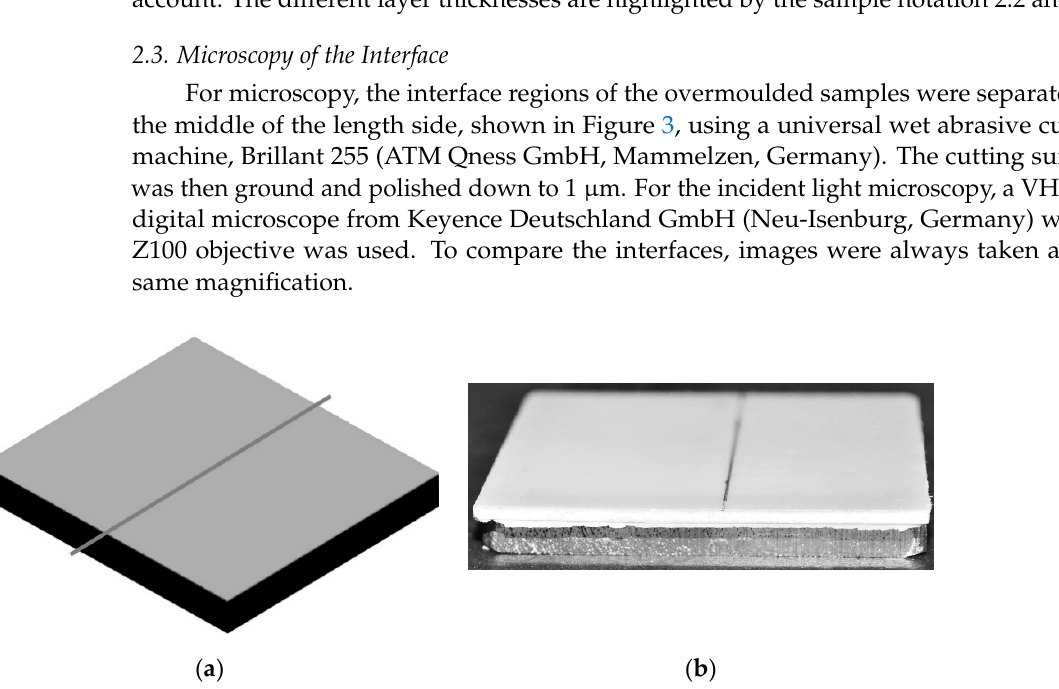
Figure 3. ( a ) Section plane considered for incident light microscopy imaging of the interface. ( b ) Overmoulded titanium insert.